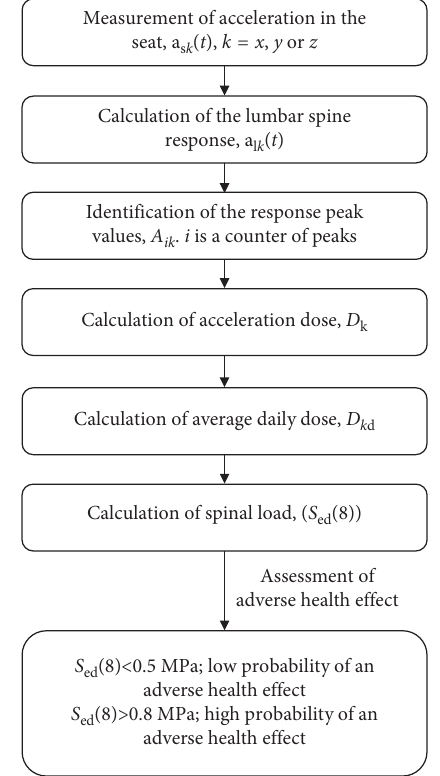
Figure 1: Evaluation of spinal load response as per ISO 2631-5